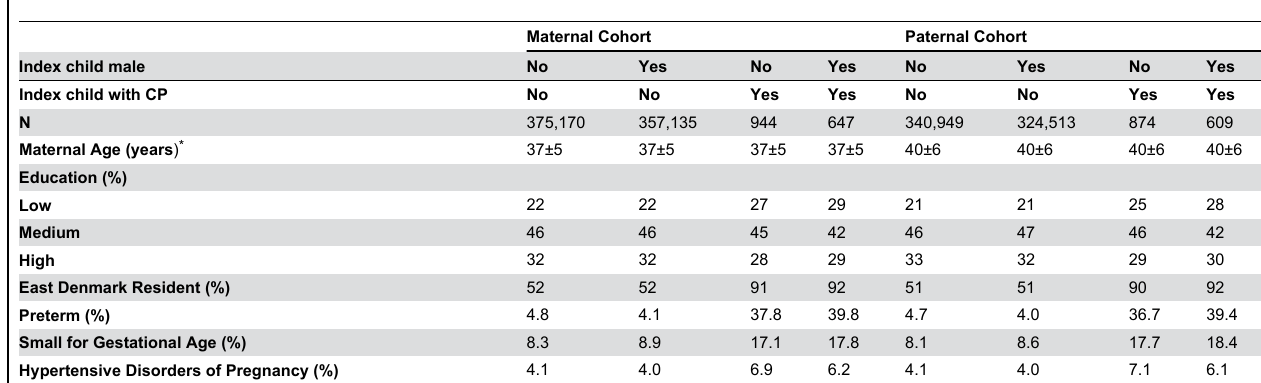
Table 1. Characteristics of the cohorts defined by sex of the parent and sex and diagnosis of CP in the child.